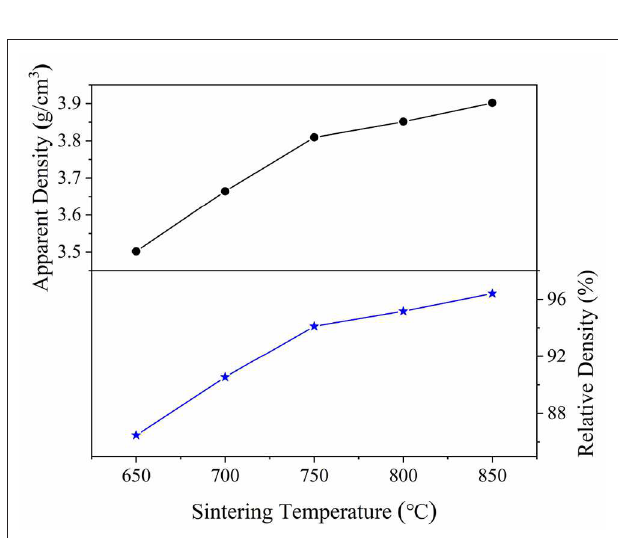
FIGURE 4 | Apparent and relative density of Ce 2 (Zr 0.94 Sn 0.06 ) 3 (MoO 4 ) 9 ceramics as a function of sintering